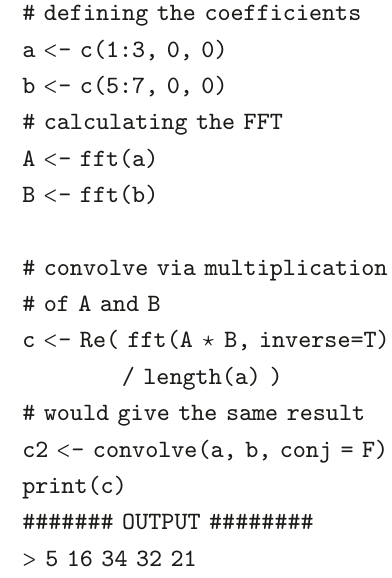
Table 2: Computation costs for the polynomial multiplication.